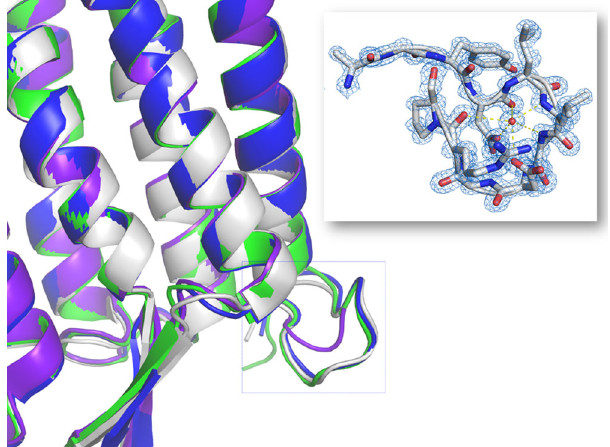
Fig. 6 Comparison of the structures the N termini of AR3 and related microbial rhodopsins. Overlay of structures of bR (5ZIM [http://doi.org/ 10.2210/pdb5ZIM/pdb] purple), AR1 (1UAZ [http://doi.org/10.2210/ pdb1UAZ/pdb] green), AR2 (3WQJ [http://doi.org/10.2210/pdb3WQJ/ pdb] blue), and LA AR3 (6S6C [http://doi.org/10.2210/pdb6S6C/pdb], white) showing the extracellular-facing omega loop, which is present in AR1, AR2, and AR3 but absent in bR. The inset shows details of the 6S6C [http://doi.org/10.2210/pdb6S6C/pdb] AR3 omega loop. Amino acids are shown in stick representation with atoms colored using the CPK convention. The 2 F obs – F calc electron density map (blue mesh) is contoured at 2.3 σ